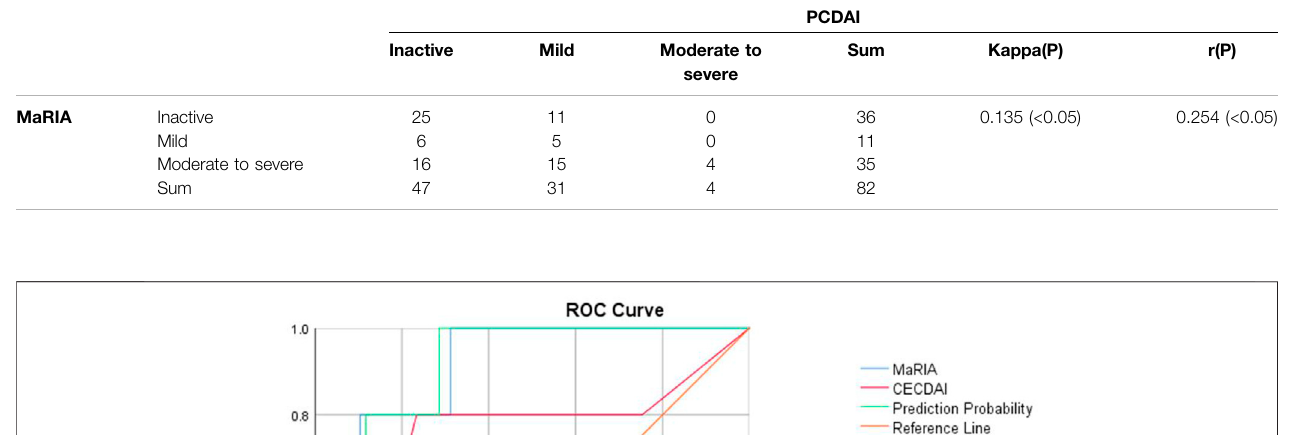
TABLE 4 | Consistency and relevance between PCDAI and MaRIA.